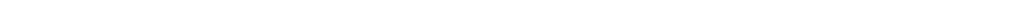
(Fig. 6j). These observations indicate that SIRT2-mediated deacetylation decreases C/EBP β ubiquitination and enhances its protein stability under ethanol stress. SIRT2 inhibits C/EBP β ubiquitination by deacetylating lysines 102 and 211